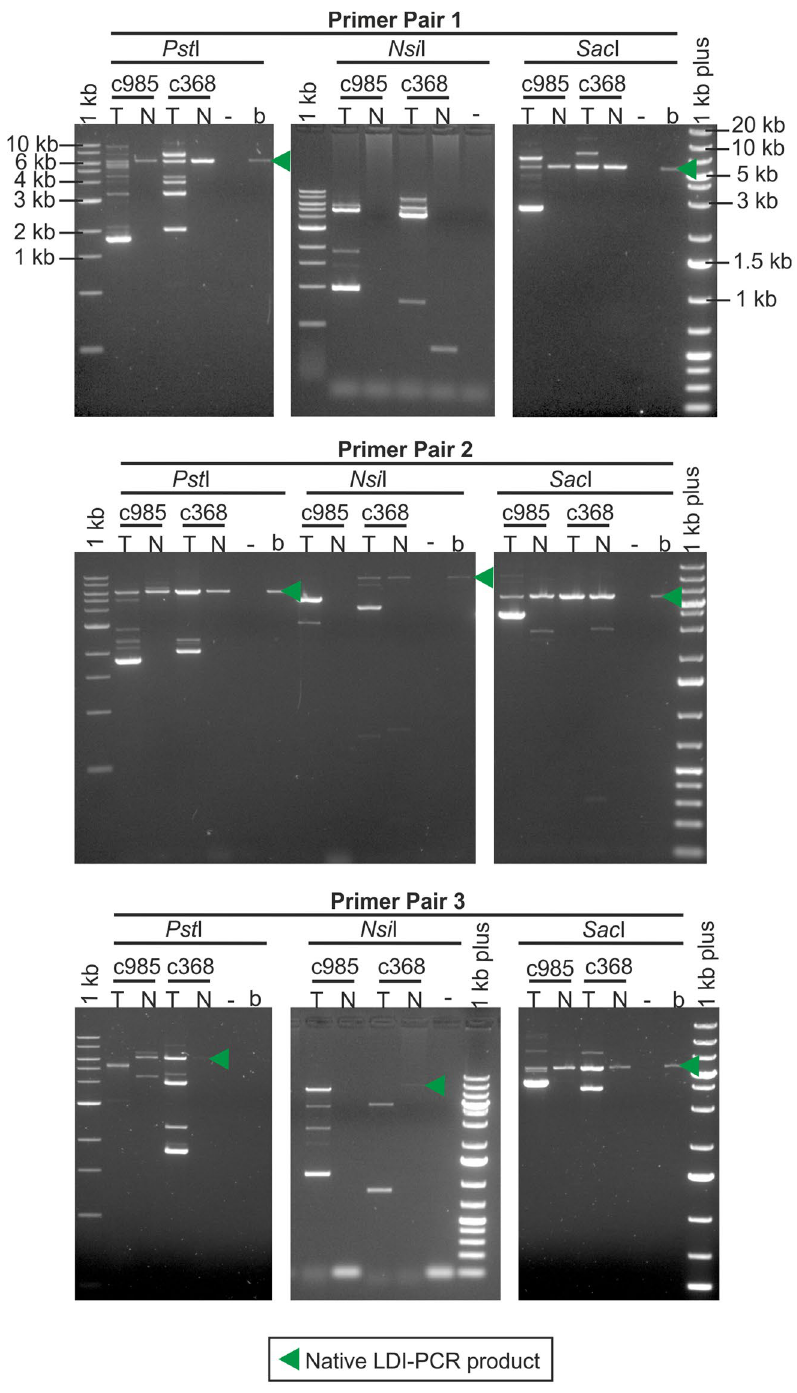
Figure 2. Agarose gel image of the LDI-PCR products. LDI-PCR using three different inverse primer pairs and restriction enzymes on two colorectal tumours (c985T and c368T) and their matching normal (c985N and c368N) DNA samples. The “native” PCR product of expected size and several additional tumour-specific products representing different putative 3 ′ transduction targets were detected. (Sizes corresponding to native LDI-PCR products: Pst I~6.3 kb, Nsi I~10.2 kb, Sac I~5.6 kb.) Digested/self-ligated blood genomic DNA sample of an unrelated individual was run in the lane labelled “b” and PCR without any template in “ −